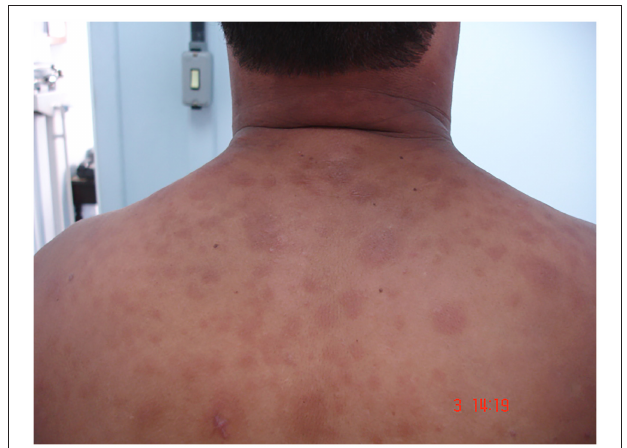
FIGURE 1 | Skin lesions of ENL patient. Image from Leprosy Laboratory collection.